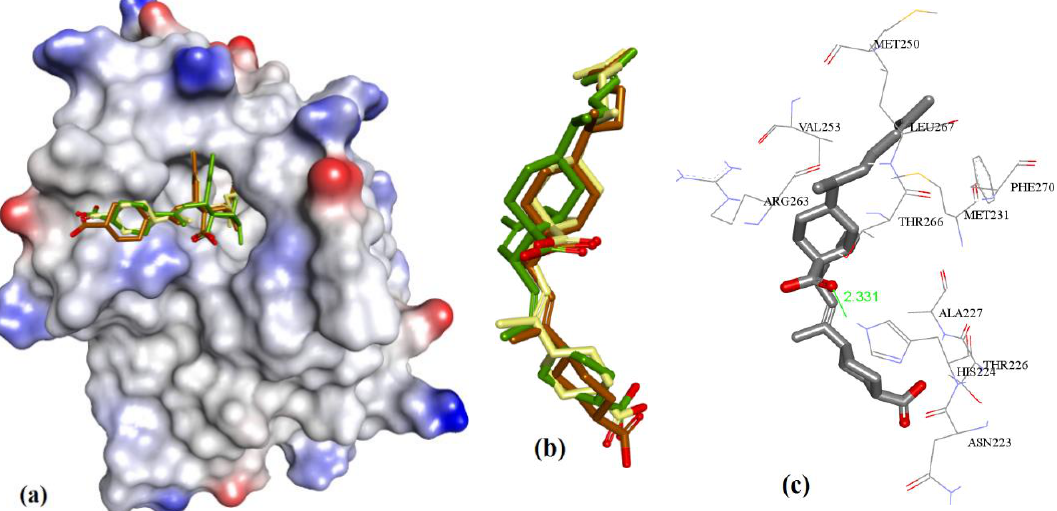
Figure 21. ( a ) The ionized solvent-exposed surface mapping of hMcl-1 along with the docked poses of 8 from MOE (in brown), AutoDock (in green), and VlifeDock (in yellow) show their fitting to the cavity. ( b ) Similar-pose ensemble clustering of all three poses was attained from the three different docking methods. ( c ) Binding mode of 8 .